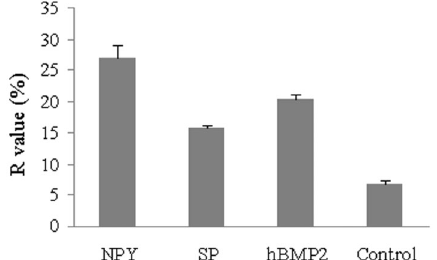
Figure 7. Fluorescence recovery of cells. The graph displays the ratio of fluorescence recovery (R) of cells exposed to neuropep- tide Y (NPY), substance P (SP) and human bone morphogenetic protein 2 (hBMP2) at the concentration of 0.1 m g/mL. The R- values of the osteoblasts after neuropeptides or hBMP2 treat- ments were all significantly higher than those of the blank control group. Meanwhile, cells exposed to NPY had the highest R-value, followed by hBMP2 and SP (P , 0.05,